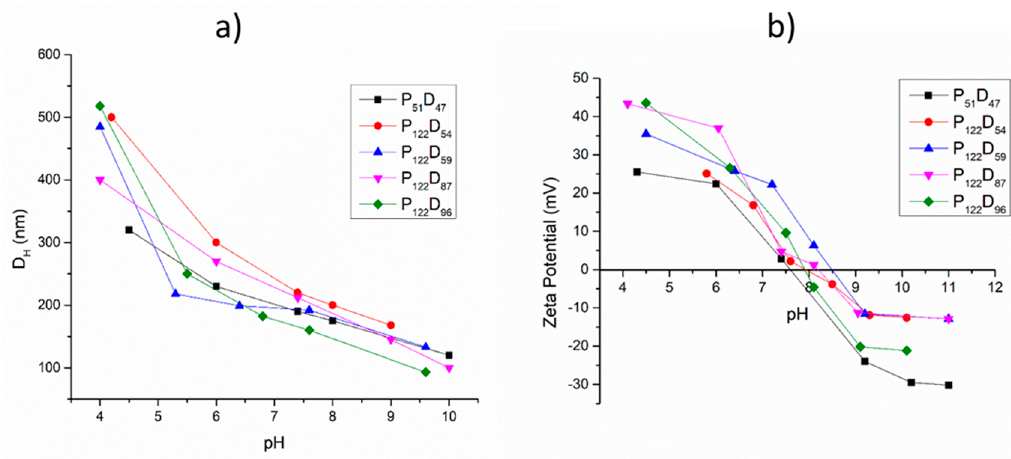
Figure 5. pH-sensitive behavior for aggregates prepared from block copolymers: ( a ) Hydrodynamic diameters obtained by DLS (0.5 mg / mL dispersion) and ( b ) Zeta potential measurements on polymer aggregates.